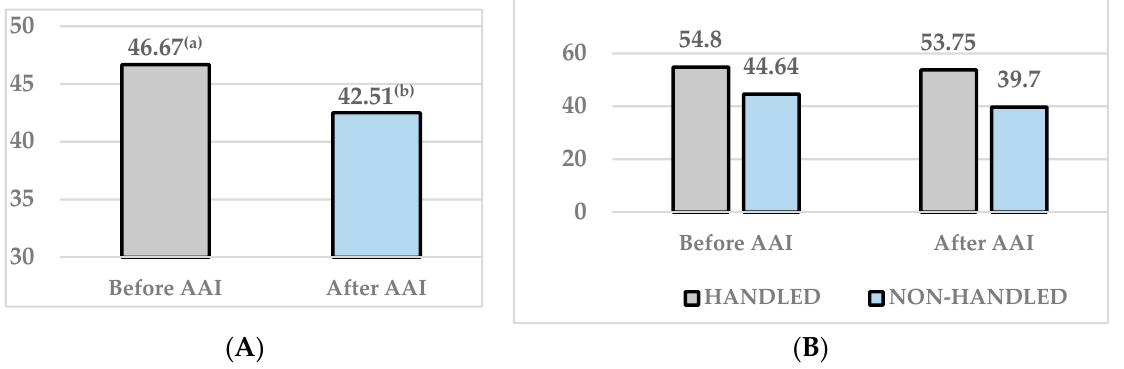
Figure 3. Owner Approach Test results: made before and after animal ‐ assisted interventions ( p = 0.0002). ( A ) Total mean and ( B ) H and NH rabbits mean. In ( A ), means with different letter marks significantly diverge from each other ( p < 0.05).